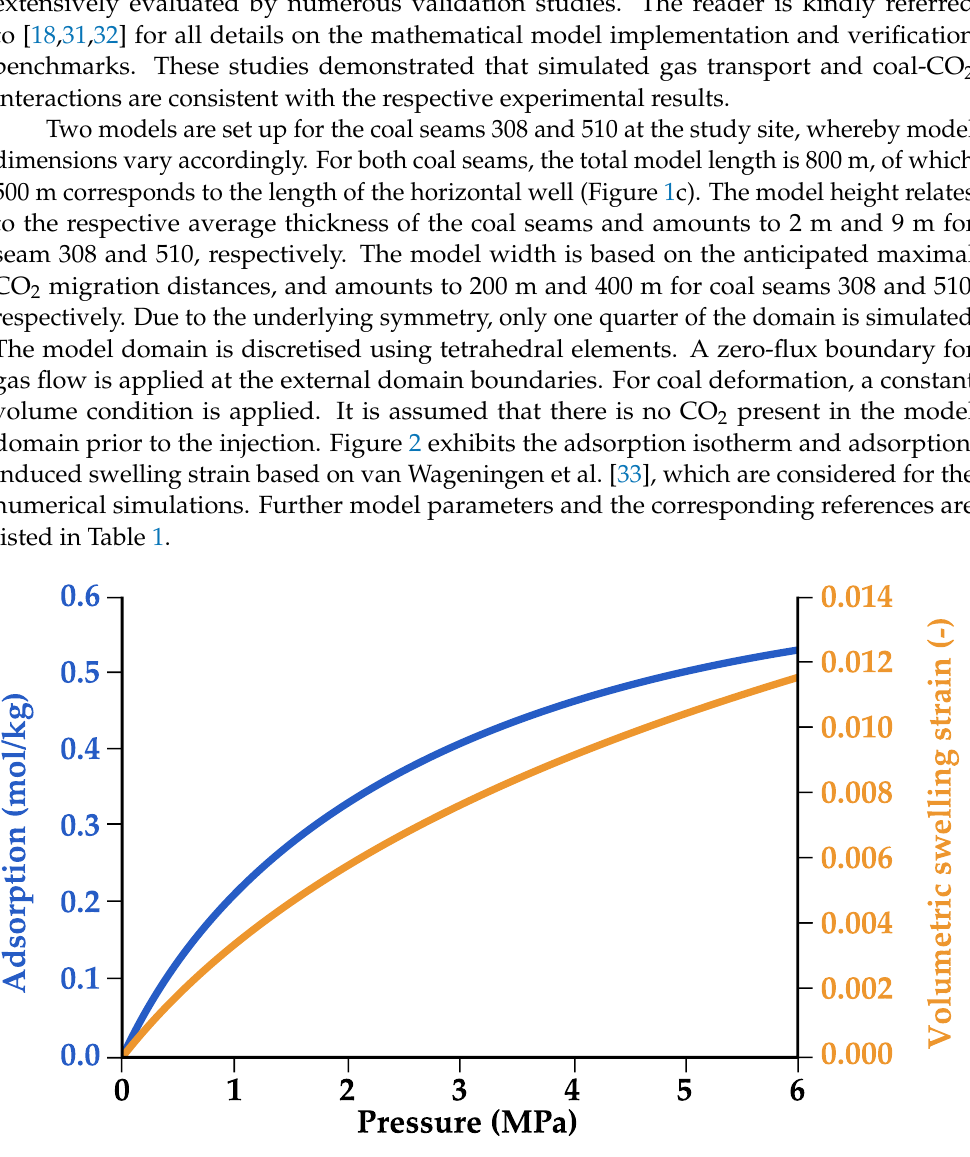
Figure 2. CO 2 adsorption isotherm (blue line) and adsorption-induced swelling strain (orange line) used in the simulations